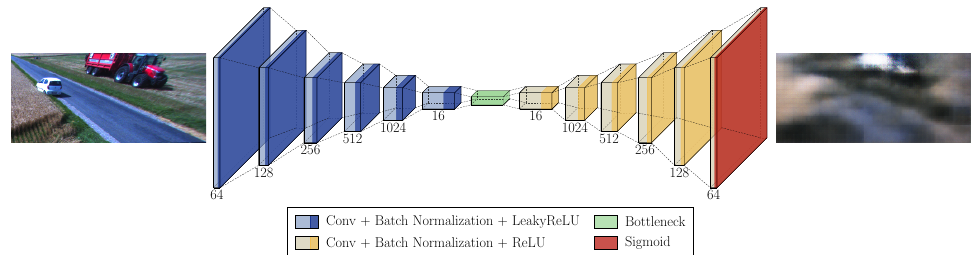
Figure 2. Illustration of the basic autoencoder architecture applied to image reconstruction task in agricultural environment. The input of the network is an RGB image of a field scene. The output is the corresponding reconstructed